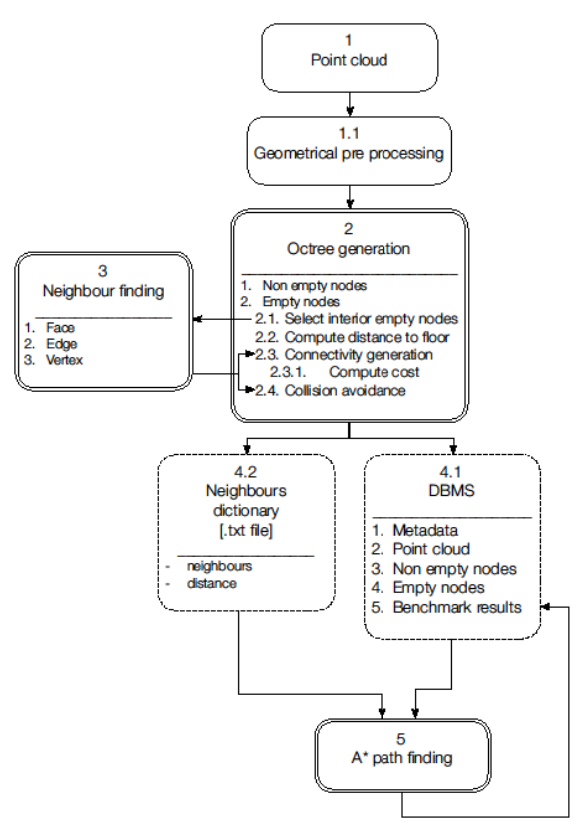
Figure 4: Workflow of the method